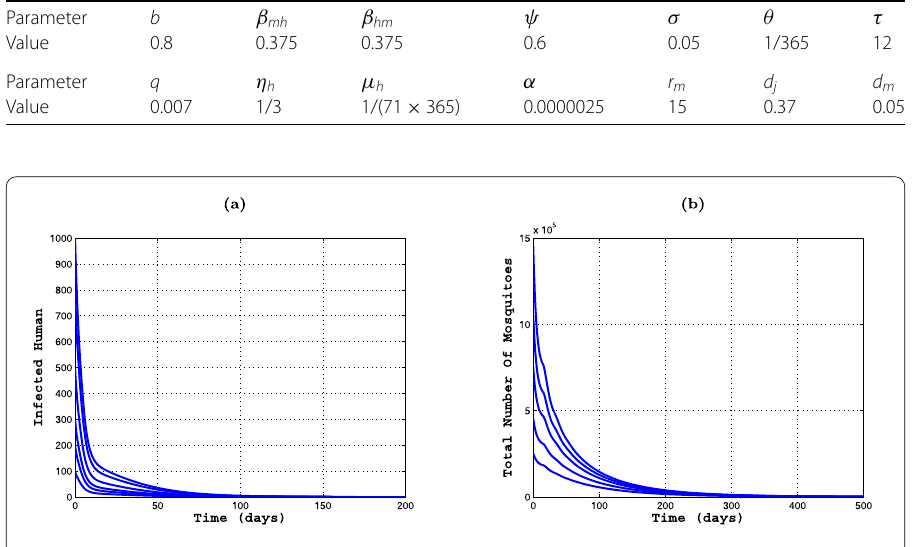
Figure 2 The global attractiveness of the disease-free equilibrium without mosquitoes E 01 of model (1), where R 01 ≈ 0.9330 <